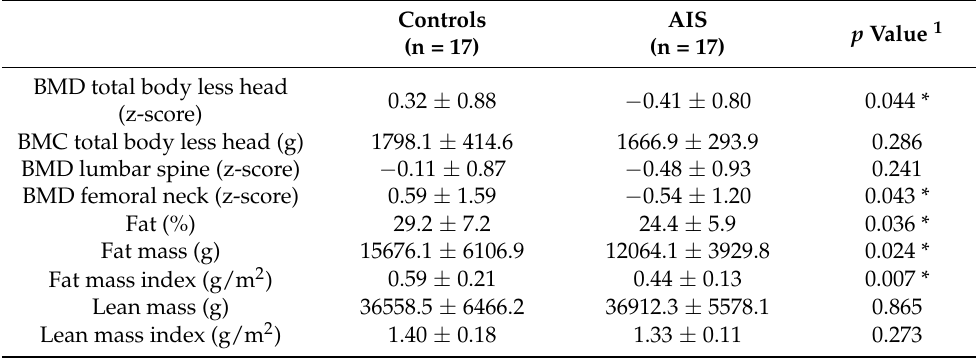
Table 2. Bone mineral density and body composition of control and AIS participants.